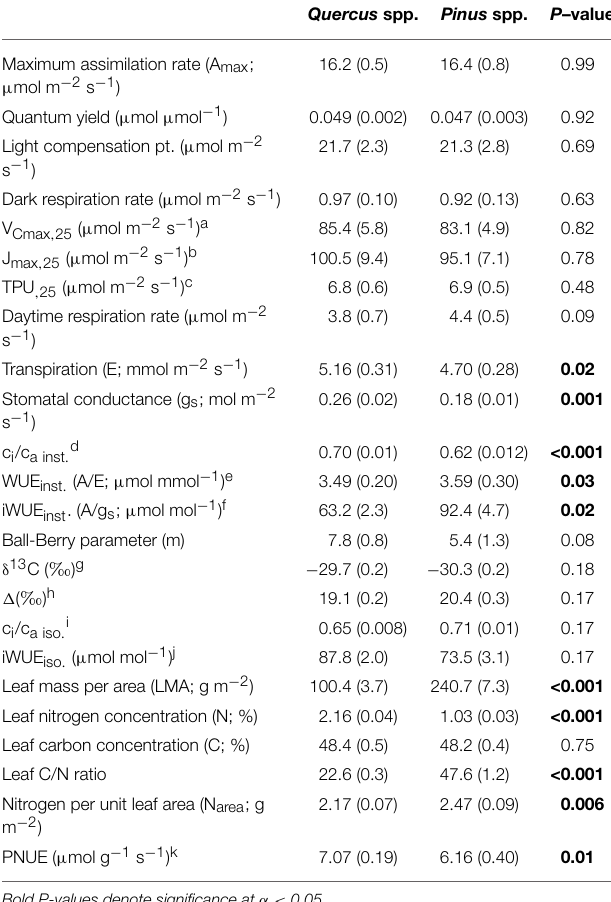
TABLE 1 | Means and standard error (in parentheses) of leaf-level gas exchange, isotope and nutrient parameters across all measured oak and pine individuals. Quercus spp. Pinus spp. P